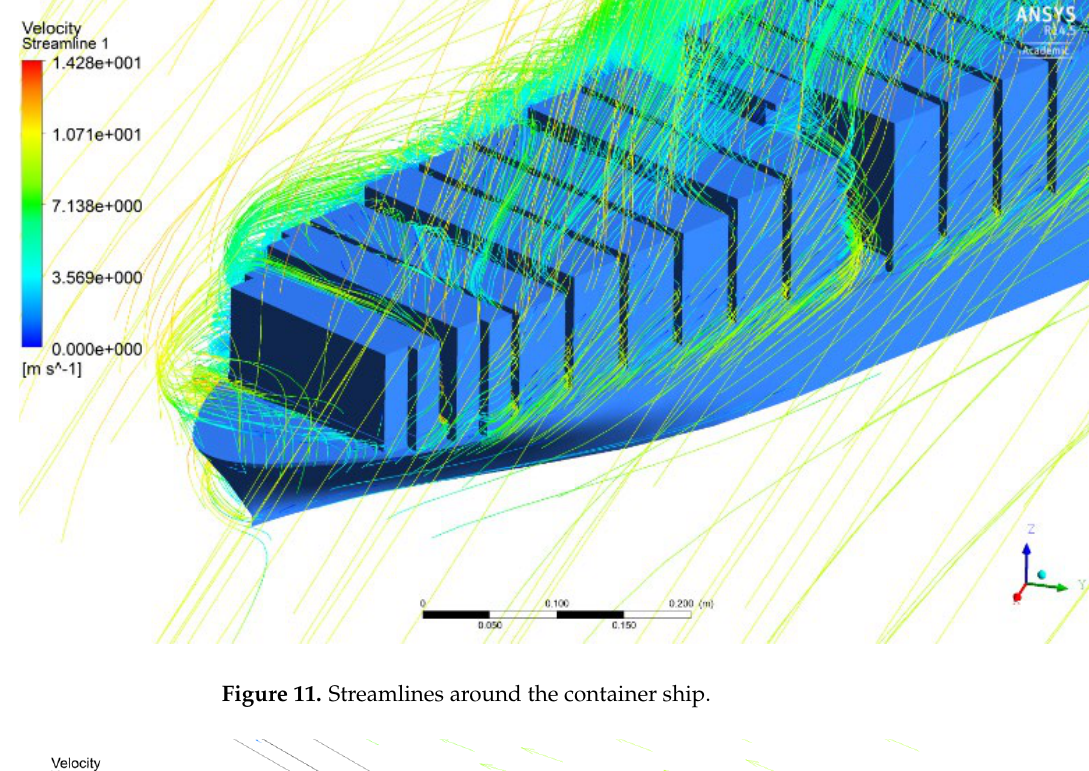
Figure 11. Streamlines around the container ship.